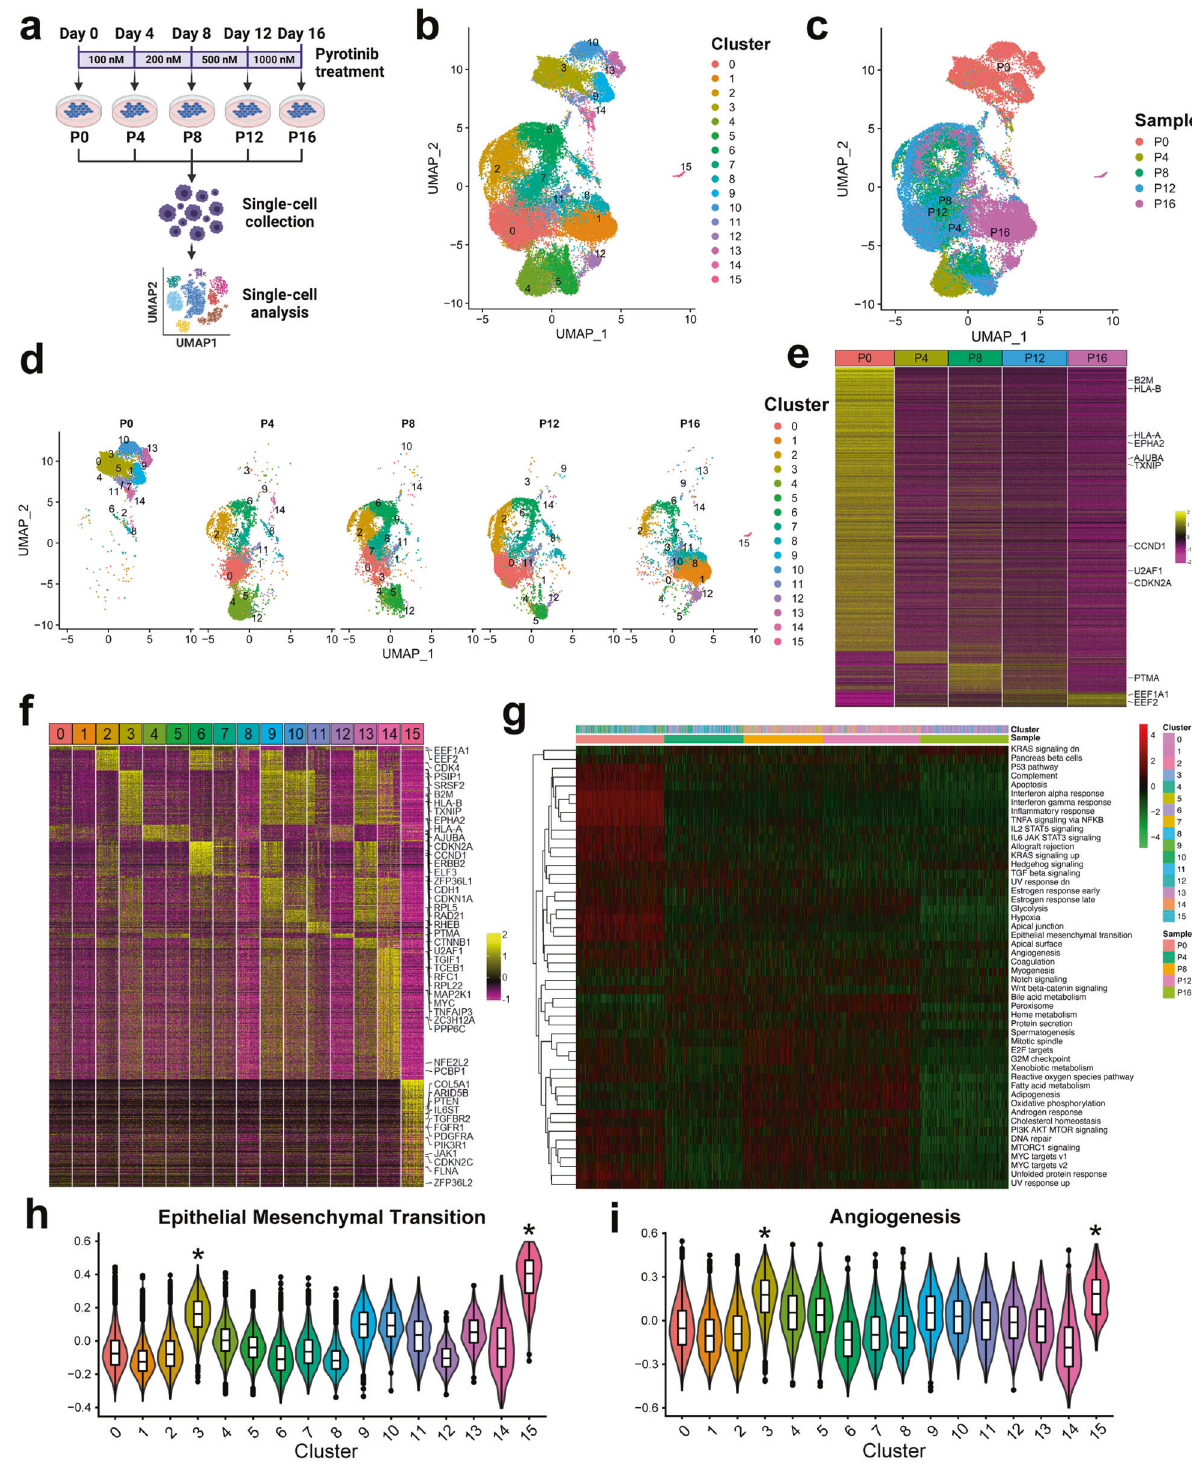
Fig. 1 Single-cell RNA sequencing revealed transcriptomic evolution of NSCLC cells in response to pyrotinib. a Flow chart of pyrotinib treatment schedule and single-cell RNA sequencing procedures. Created with BioRender.com. b Umap illustration of cells colored by clusters. c Umap illustration of cells colored by samples. d Umap illustration of cells colored by clusters in separate samples. e Heatmap of signi fi cantly differentially expressed genes among the cells in various samples with cancer gene annotations. f Heatmap of signi fi cantly differentially expressed genes among the cells in various clusters with cancer gene annotations. 125 cells in each cluster were randomly chosen for illustration. g Heatmap illustrating the overview of GSVA scores of cancer hallmark signatures in different samples and clusters. h , i Violin plots of GSVA scores of ( h ) EMT and ( i ) angiogenesis for cells in different clusters. Signi fi cance * indicates FDR < 0.05 and |log2 fold change | > 0.5 compared to other groups